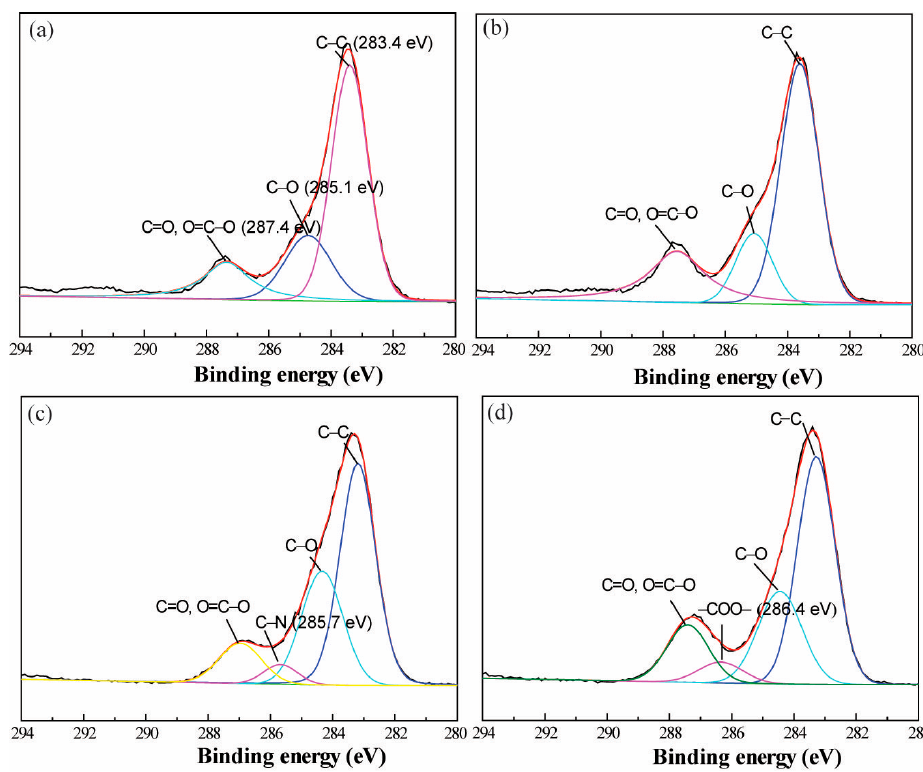
Figure 6. The simulated carbon (C1s) XPS analysis of pristine fabric ( a ); alkaline treated fabric ( b ); (PDADMAC/PAA) 3.0 -PET fabric ( c ) and (PDADMAC/PAA) 2.5 -PET fabric ( d ).